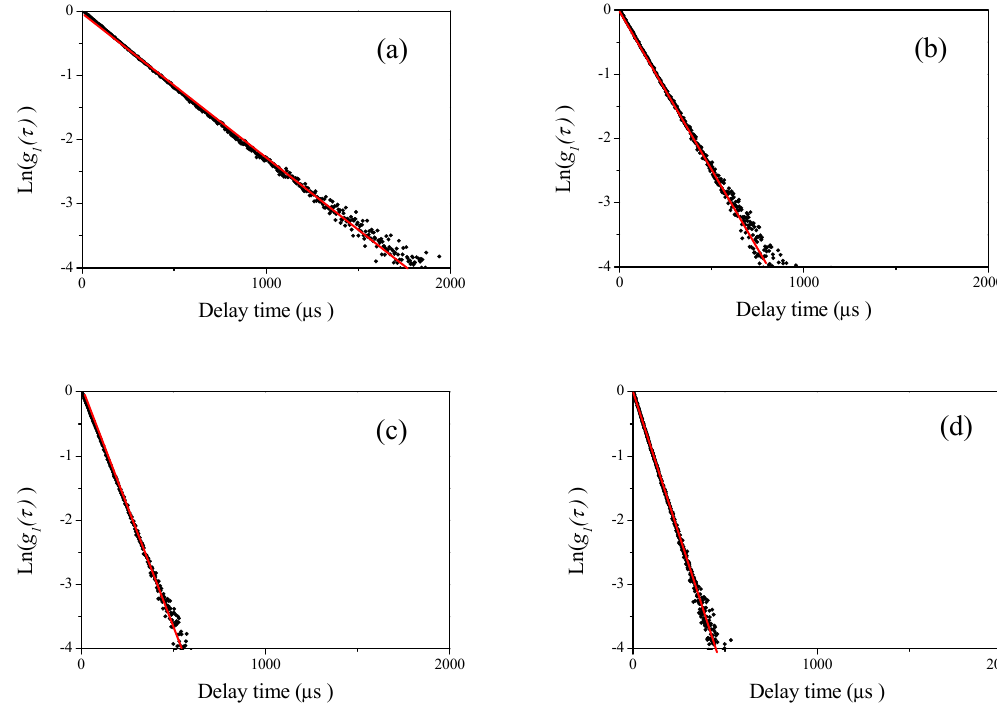
Figure 2. Examples of the observed homodyne photon correlation functions for polystyrene latex particles (W15BG001) using the dynamic light scattering (DLS) method (filled circles). The concentration of the aqueous polystyrene latex particle suspension was 0.1 mg/mL. The red line is the linear least-squares fit of the experimental results. ( a ) Detector angle of 60°, ( b ) detector angle of 90°, ( c ) detector angle of 120°, and ( d ) detector angle of 150°.